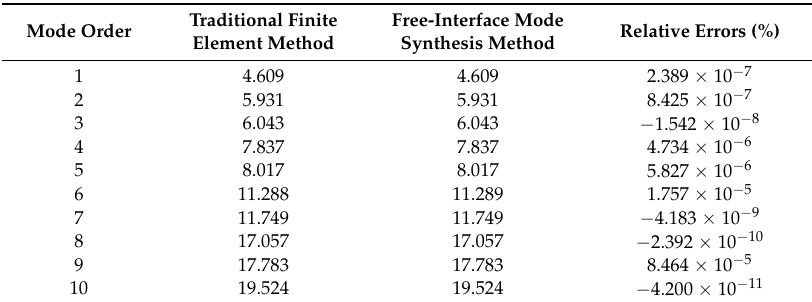
Table 2. The first 10 natural frequencies